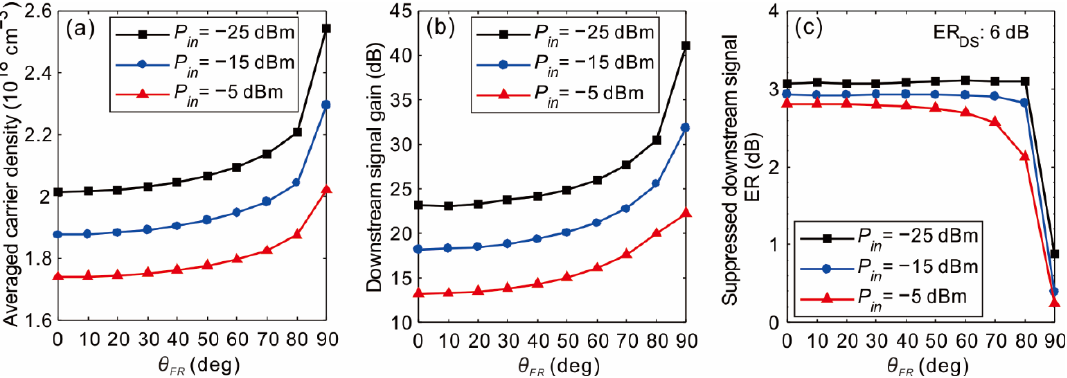
Figure 3. ( a ) Averaged carrier density inside the SOA active region, ( b ) the downstream signal gain, and ( c ) extinction ratio (ER) of the suppressed downstream signal as functions of the Faraday rotation angle. (ER DS : ER of the downstream signal at input).